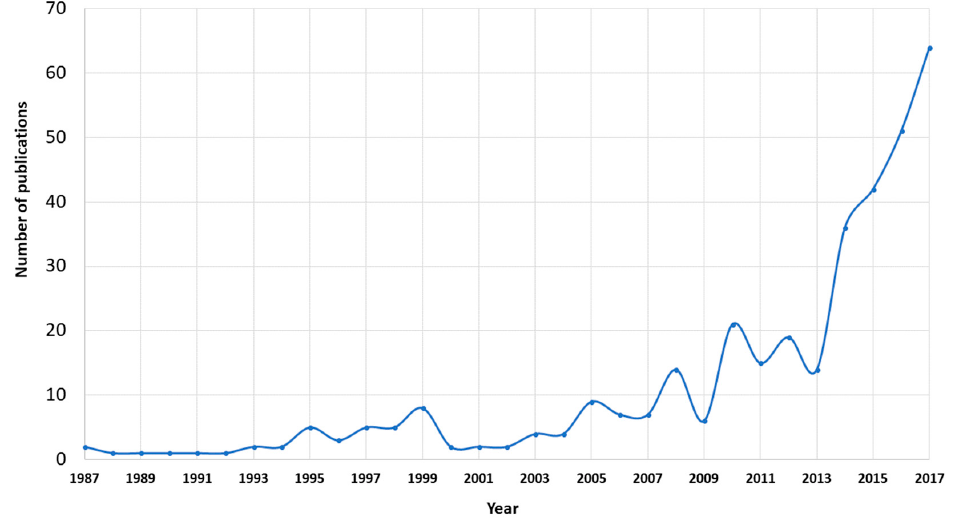
Figure 2. Evolution of scientific production in the last 30 years in relation to unaccompanied minors.